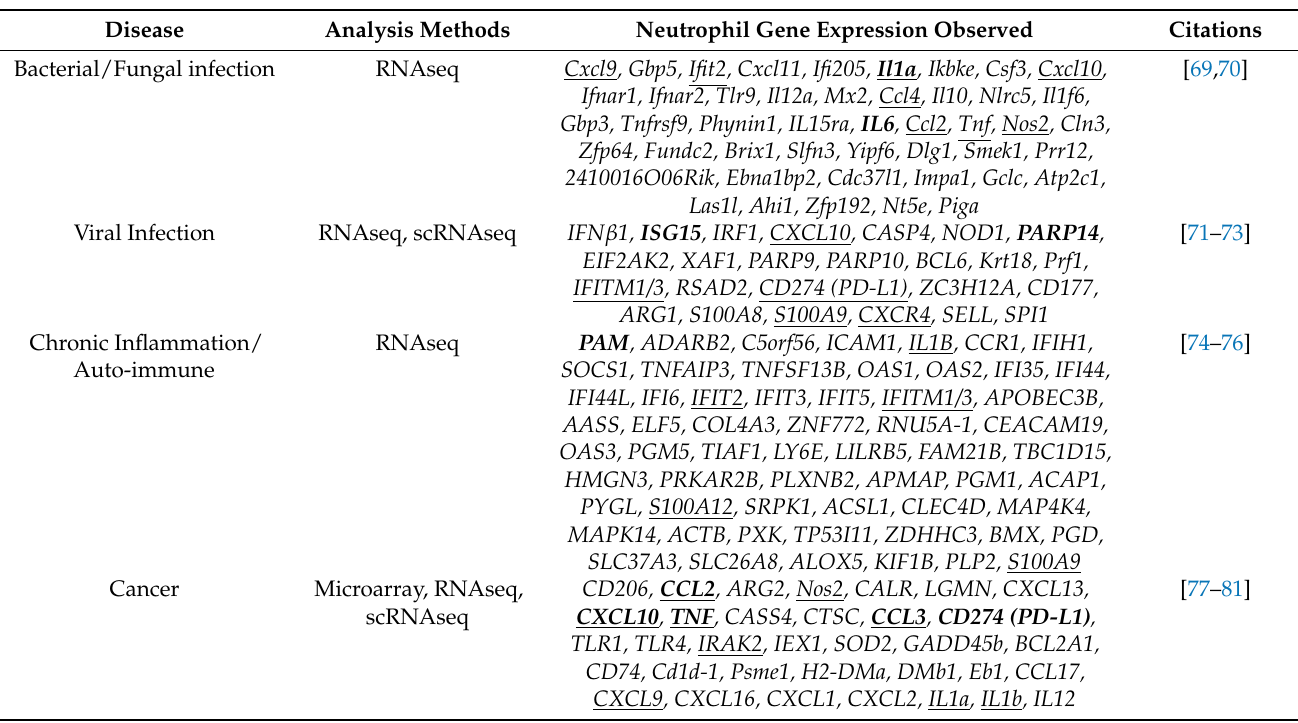
Table 2. Summary of neutrophil gene expression reported in major diseases. Genes featured are restricted to those highlighted by the original authors and/or the largest fold change reported by the study. Bold indicates common to the studies cited, underlined indicates common to multiple diseases. RNAseqRNA sequencing; NETosis—neutrophil extracellular trap formation. Disease Analysis Methods Neutrophil Gene Expression Observed Citations Bacterial/Fungal